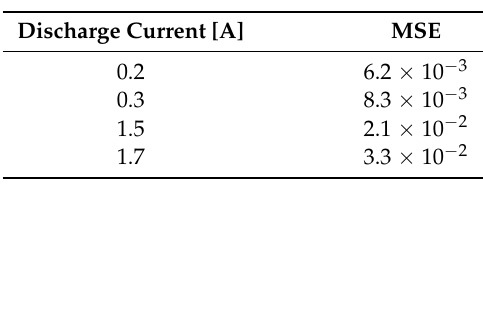
Figure 4. Test for a discharge current of 0.3 A: comparison between the voltage estimated by means of a closed-form parameter-based model and the voltage reference values (on the left ). Absolute Error in logarithmic scale between simulated and reference values (on the right ). Table 5. MSEs for different cases of